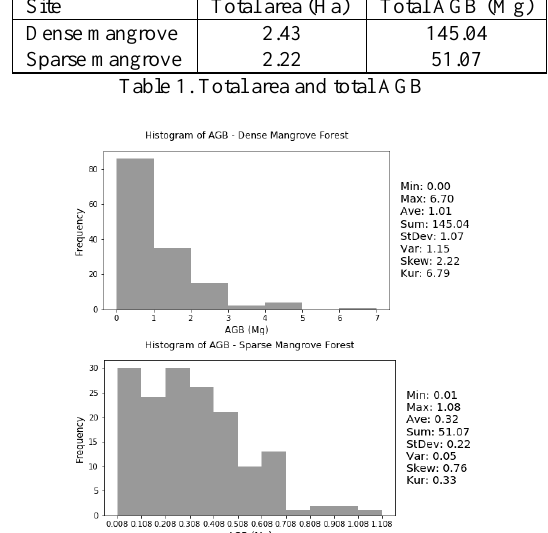
Figure 6. Histogram of AGB of the two field